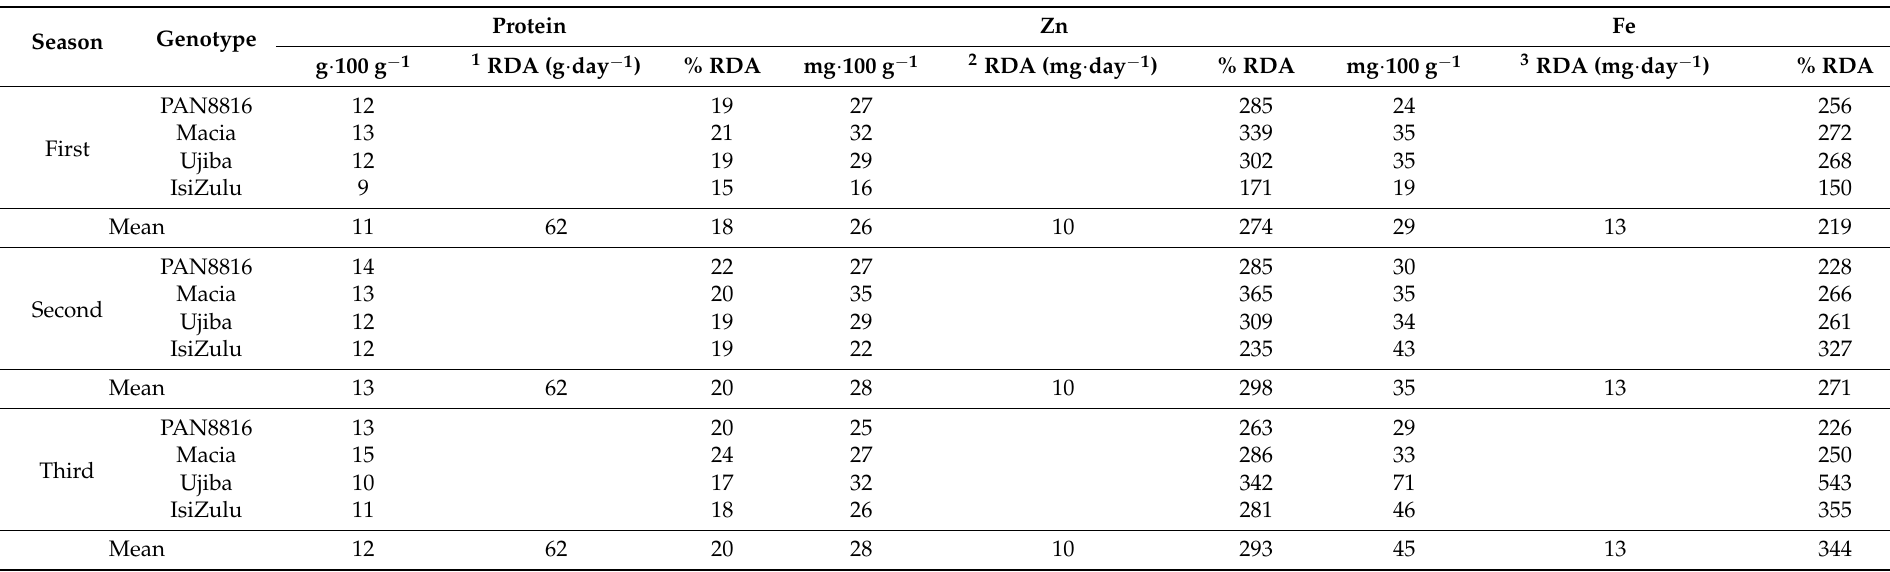
Table 4. Protein, zinc and iron contribution to the required dietary allowance (RDA) of different sorghum genotypes grown at different planting dates. Season